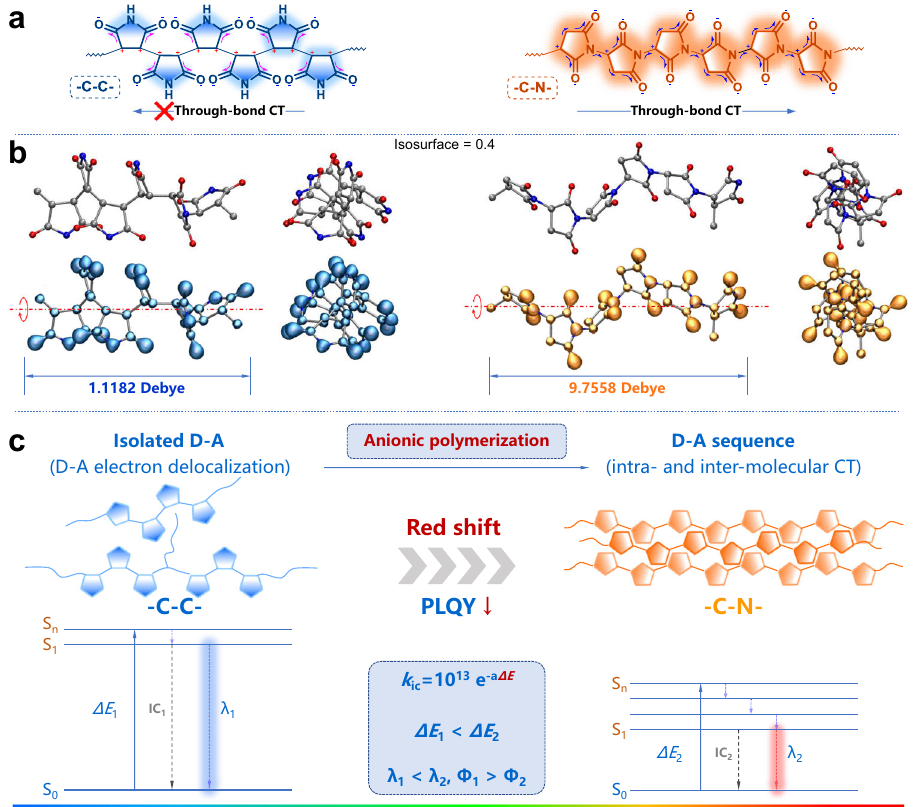
Fig. 5 Schematic illustration of the nonconventional luminescence of PMs. a , b Typical molecular structures, the optimized electronic structures and electron density distribution of the PMs in – C – C – and – C – N – connections calculated using Gaussian 09 with uB3LYP/6-31 G ( d ) method. c Schematic illustration the redshift of emission spectra and PLQY drop from – C – C – connected PM and – C – N – connected platform for rational molecular design to achieve full-color nonconventional luminescence far beyond their potential appli- cations in security printing, fi ngerprint identi fi cation, metal ion recognition, etc.